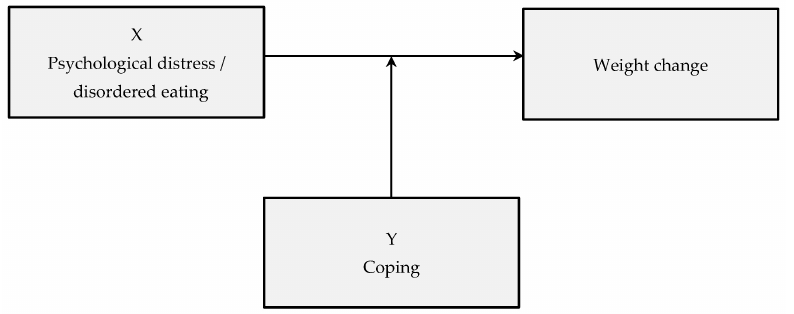
Figure 1. The moderating role of coping in the causal relationships of psychological distress and disordered eating with weight change.